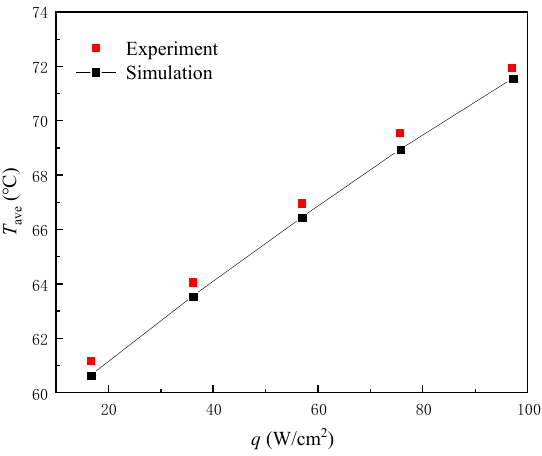
Figure 3. Comparison of average temperature between simulation and experiment.